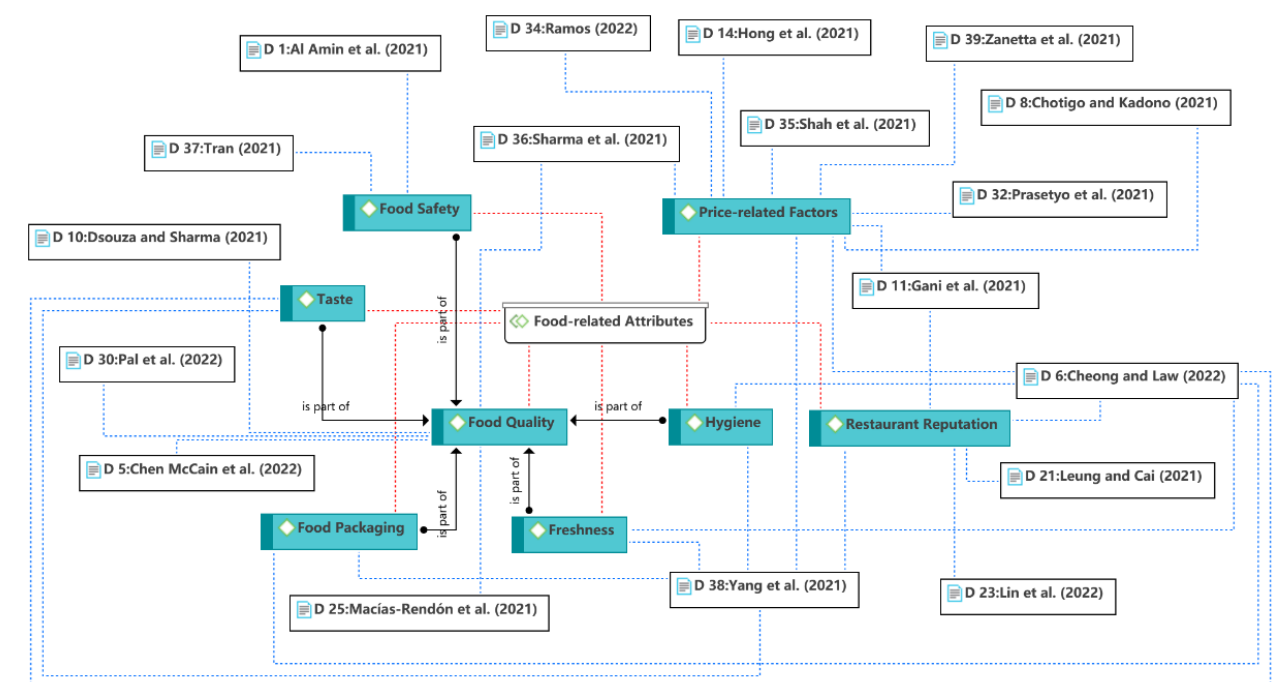
Figure 12. Theme 8: food-related attributes [12,14,24,27,35,36,40,42,44,46 – 51,53,59,61].